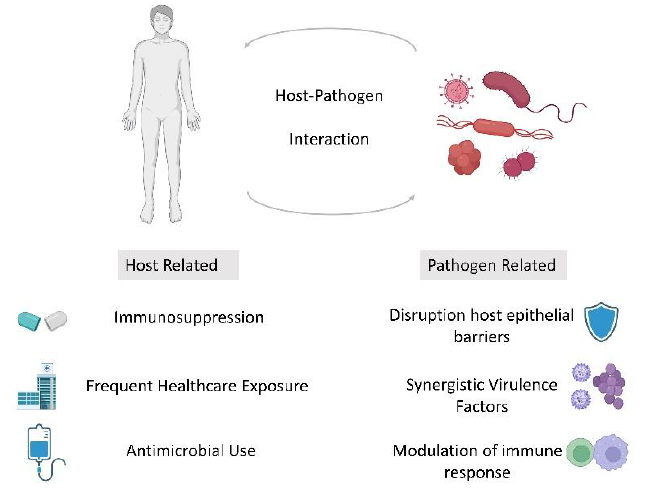
Figure 1. Schematic of factors which may contribute to polymicrobial infection in the immunocom- promised host.